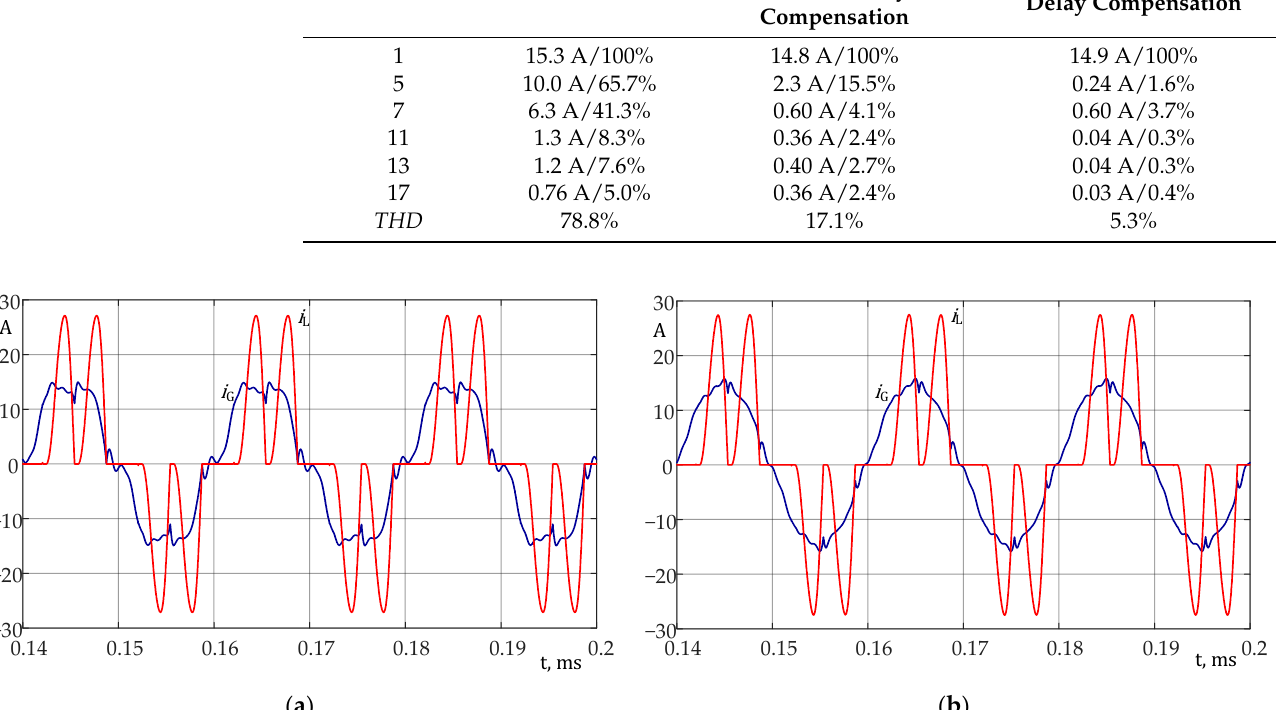
Figure 9. Operation of HAPF with CL2 control loop: ( a ) without and ( b ) with the time delay compensation.